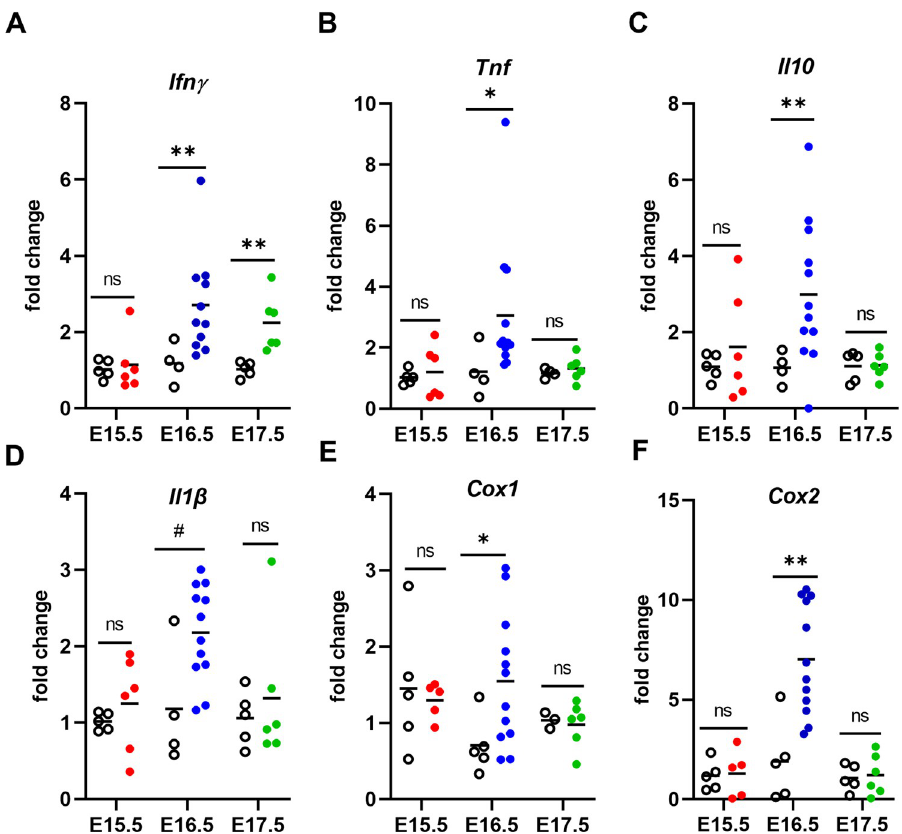
Fig 5. P . chabaudi infection at E8.5 induces upregulation of inflammatory and parturition-associated gene transcripts in the E16.5 placenta prior to preterm delivery. (A-F) Mouse Ifn γ , Tnf , Il10 , Il1 β , Cox1 , and Cox2 mRNA abundances normalized to Ubc and quantified by qPCR in placentae taken from infected pregnant (solid color circles) and uninfected pregnant (open black circles) dams. Solid color circles denote pooled placentae from individual infected dams sacrificed on E15.5 (red), E16.5 (blue), and E17.5 (green). Open black circles are pooled placentae from uninfected pregnant controls for each group. Group means and transcript abundance in individual mice are depicted. �� P � 0.005, � P < 0.05, unpaired t-test with Welch’s correction; ns = not significant, P > 0.05; # denotes a trending result, P = 0.08. E16.5 for superoxide dismutases 1 and 2 ( Sod1 , Sod2 ), catalase ( Cat ), and nuclear factor ery- throid-2 related factor 2 ( Nrf2 ) were significantly elevated compared to UP controls (Fig 7A, 7B, 7D and 7E). None of these targets were significantly elevated in IP mice infected and euthanized at the other time points (Fig 8). However, when the relationships between antioxidant transcript abundance and parasitemia were considered at E15.5 in the E6.5 infection group, Hmox1 and Cat positively correlated with placental parasitemia. Additionally, Hmox1 positively correlated with peripheral parasitemia AUC (Fig 6C–6E). In the E8.5 infection group, E16.5 placental Sod3 transcripts tended to correlate negatively with both peripheral parasitemia at sacrifice and parasitemia AUC (Fig 9). Significant correlations between antioxidant transcript expression and parasite burden were not found in the placenta at E17.5 in the E10.5 infection group. Linear regression modeling was applied to assess factors important in driving differences in placental antioxidant gene expression. As with inflammatory markers, this analysis considered infection status, day euthanasia was performed, uterus weight, number of embryos and embryo viability. The latter three were considered together and did not predict antioxidant transcript abundance. Infection status drove significant increases for genes except Sod3 (p � 0.04; S4